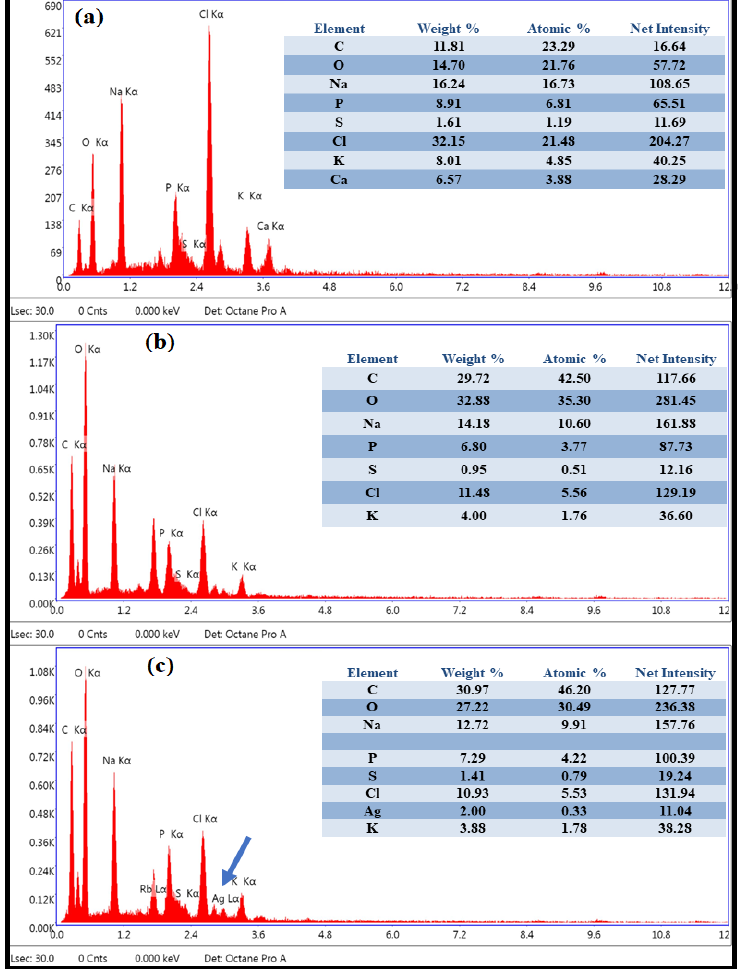
Figure 8. Elemental analysis (EDS) of sporangiospores: ( a ) control, ( b ) treated with PEI-f-AgNP-1, and ( c ) treated with PEI-f-AgNP-2 for 24 h.